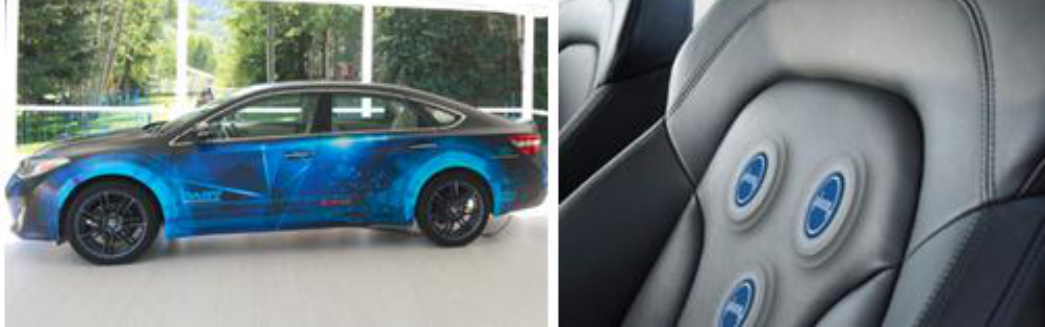
Figure 4. Toyota’s DARV 1.5 and Plessey’s EPIC Seat Sensors. Image credit: